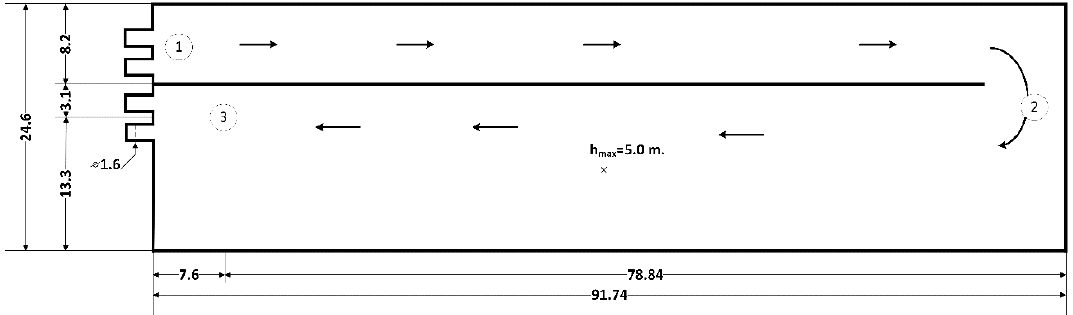
Figure 5. Plant view of chlorination tank 1 (measured in meters).